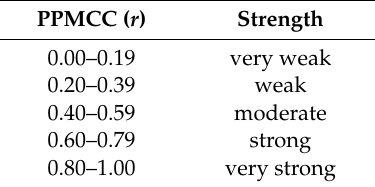
Table 7. The guidance for the strength of the correlation by Evans [25].